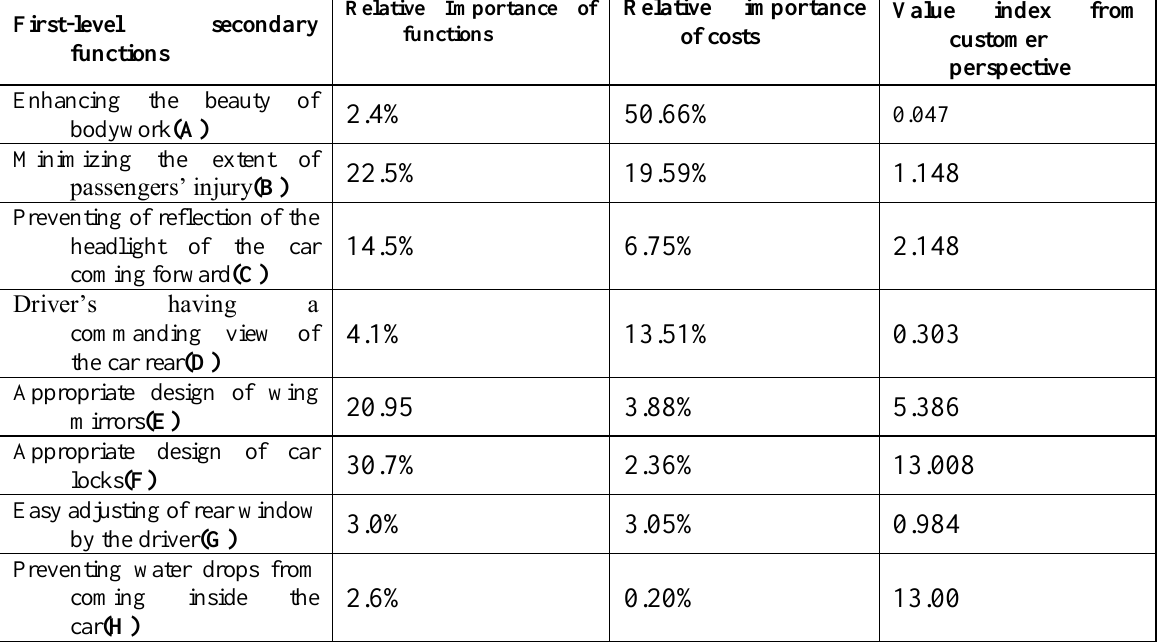
Figure 7. The value index of